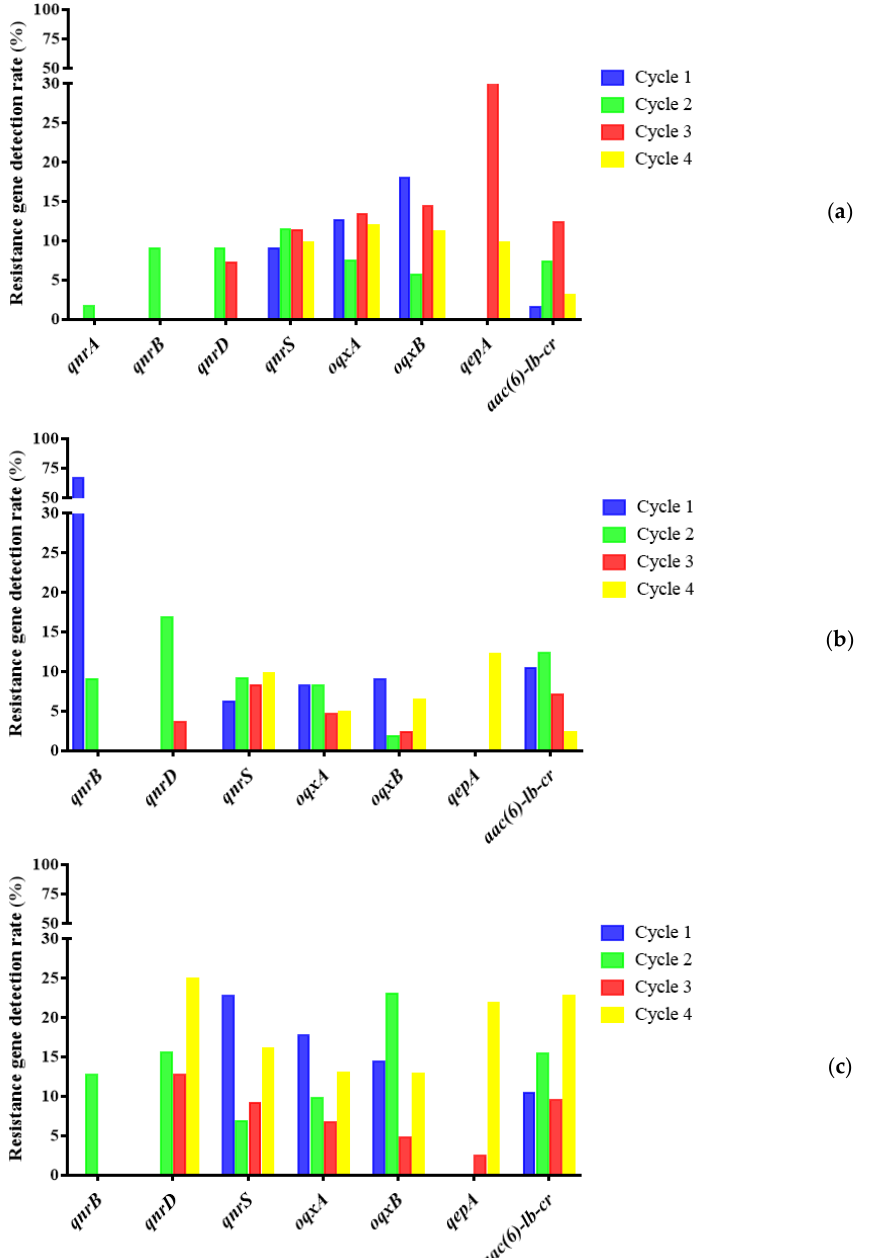
Figure 7. ( a ) The proportion of strains with positive drug resistance genes from chicken seedlings in different cycles. ( b ) Proportion of all positive strains of each drug resistance gene from feed in different cycles. ( c ) Proportion of all positive strains of each drug resistance gene from fecal water and feces in different cycles.